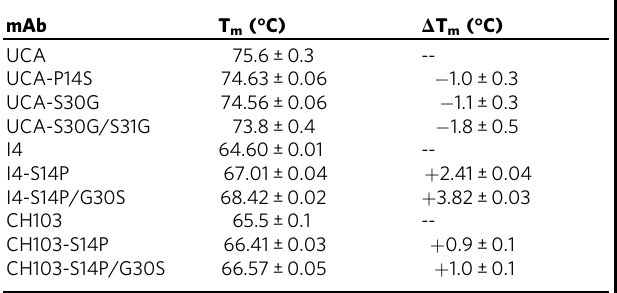
Antibody thermal denaturation pro fi les were obtained and analyzed by DSC as described in Methods. Data are shown as the mean and standard deviation from a minimum of two replicate measurements. The Δ T m is calculated for each mutant relative to wild-type with error propagated from the standard